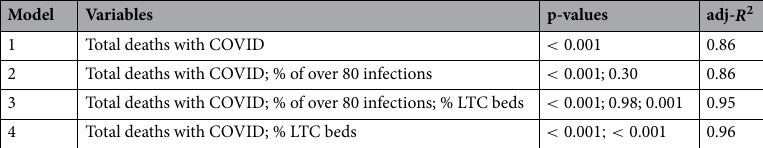
Table 6. Multivariate models explored. Independent variables; p -values; and adjusted- R model.